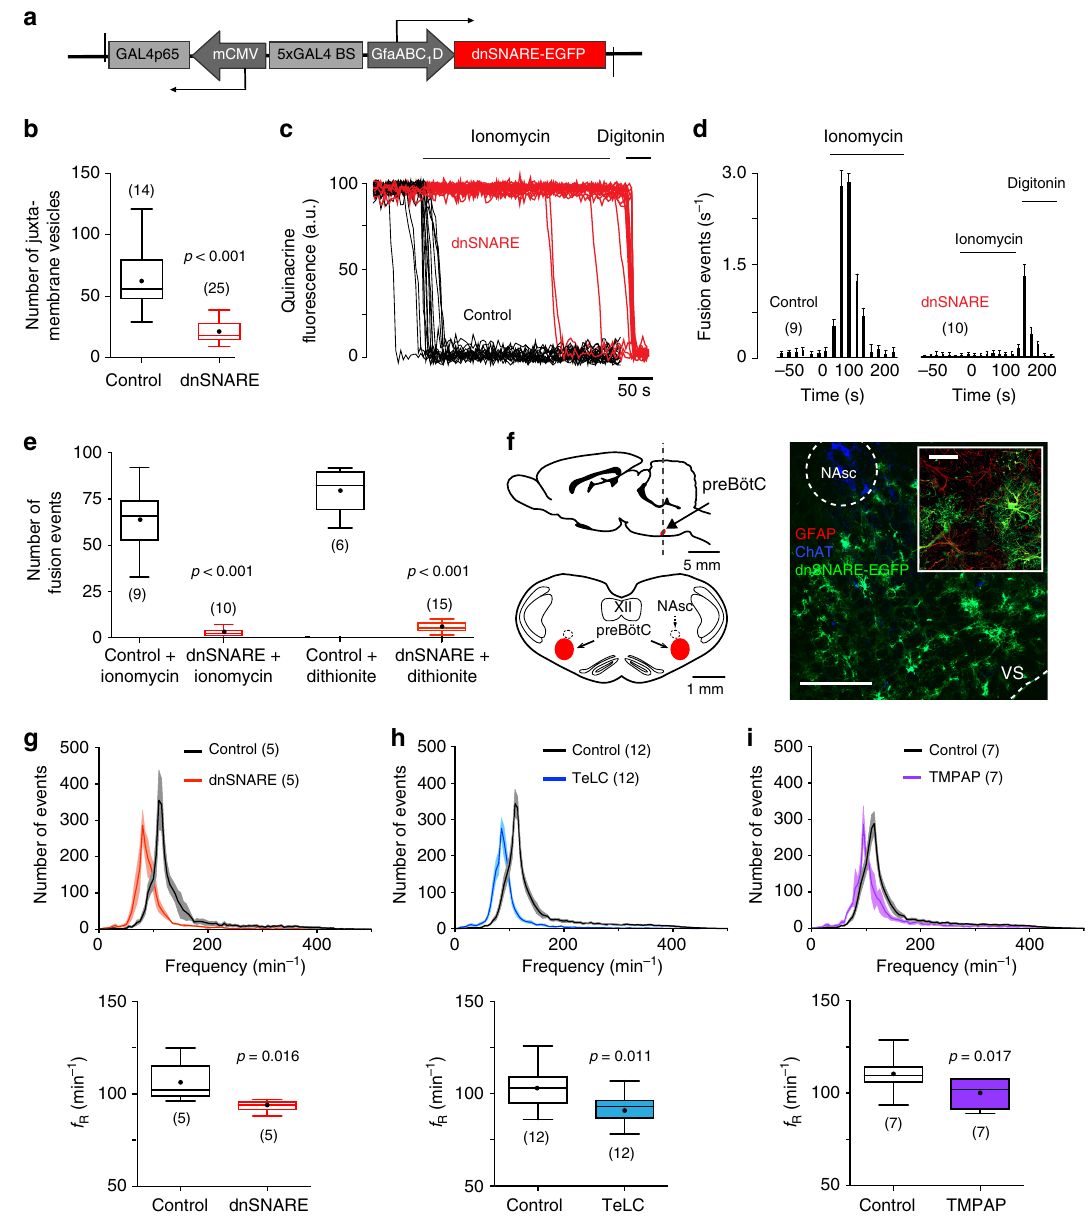
Fig. 1 PreBötC astrocytes modulate the activity of the respiratory rhythm-generating circuits. a Schematic of AVV-sGFAP-dnSNARE-EGFP vector